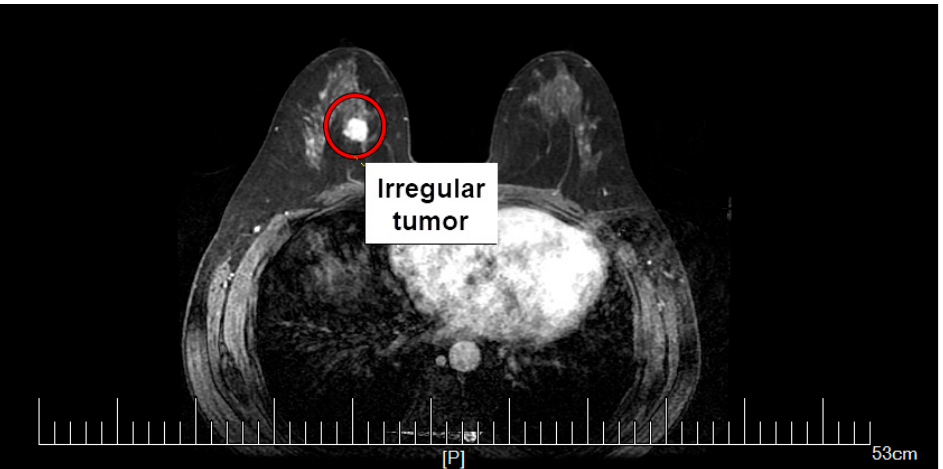
Figure 1. Screening mammography of the breast tumor. Reproduced with kind permission from Dalian University of Technology, China.